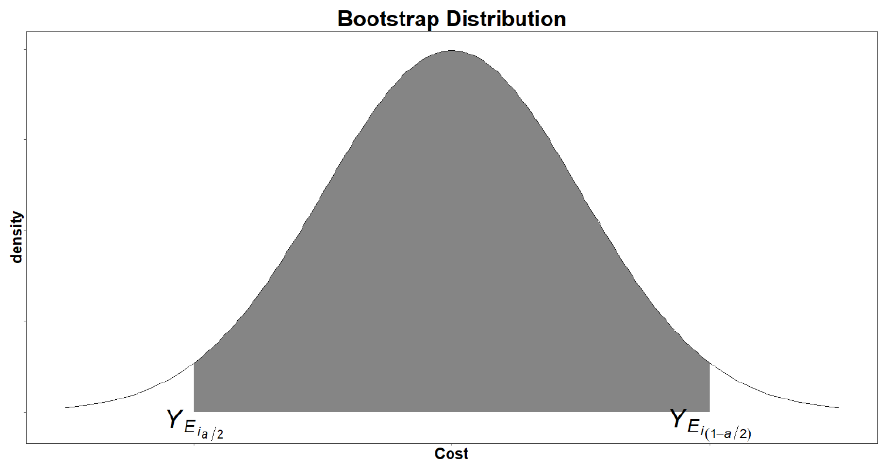
Figure 1. Bootstrap distribution with (1 − ) % empirical prediction interval.